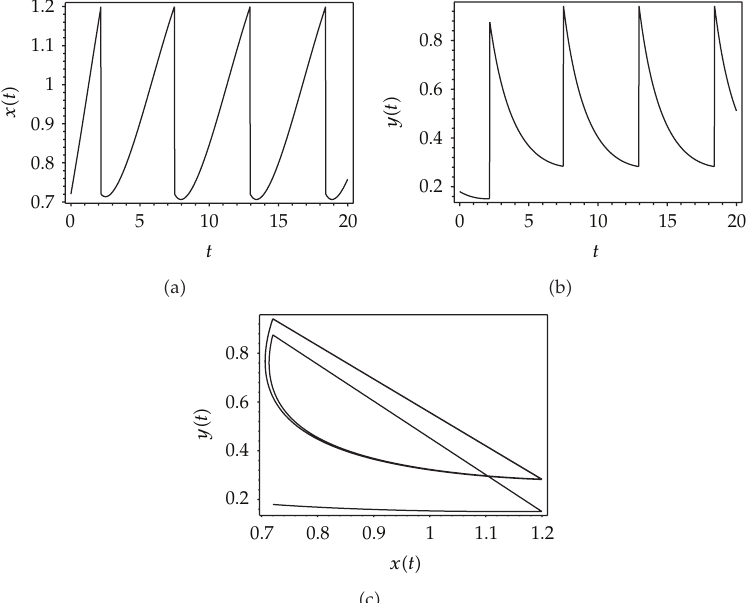
Figure 8: Time series and portrait phase of system (cid:6) 1.3 (cid:7) with p (cid:8) 0 . 4, q (cid:8) 0 . 5, x 0 (cid:8) 0 . 72, y 0 (cid:8) 0 . 18, and h (cid:8) 1 . 2 < x ∗